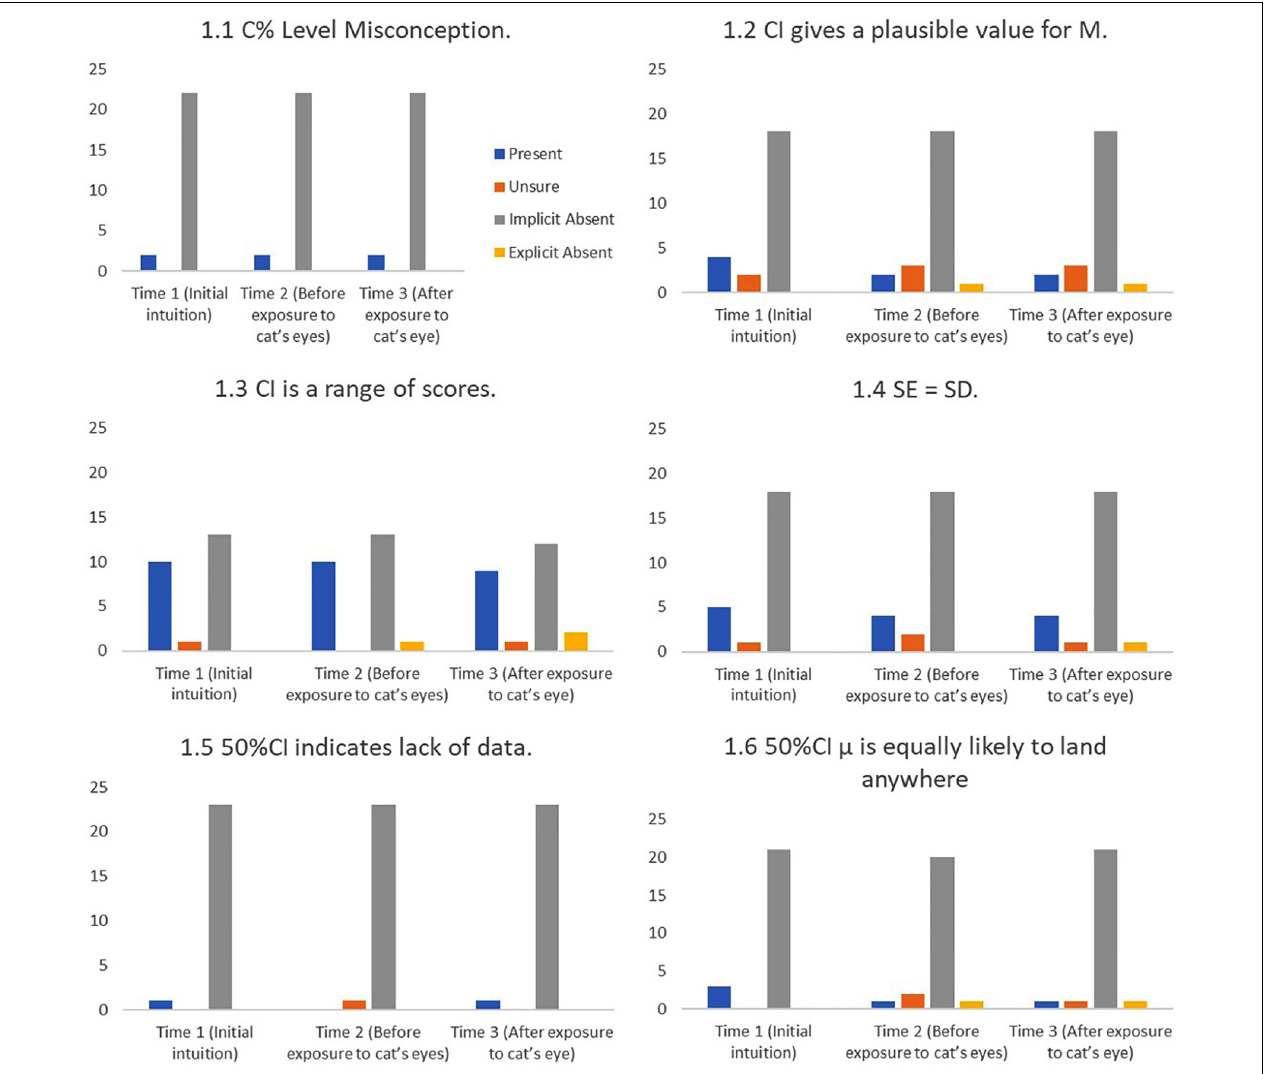
FIGURE 8 | Frequency of students stating intuitions at first mention (Time 1), at last mention immediately before exposure to cat’s eye program (Time 2), and after exposure to cat’s eye program (Time 3) for definitional misconceptions ( n =